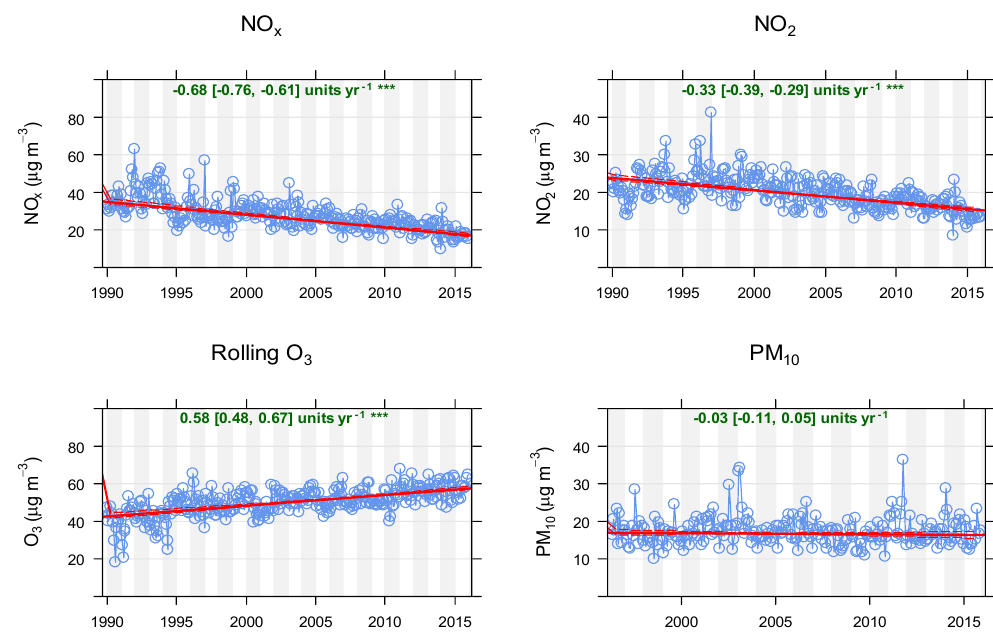
Figure 4. Malmö: trends in NO x , NO 2 , O 3 , and PM 10 , measured from 1990 to 2015. For PM 10 , data are only for the period of 1996–2015. The blue rings are the deseasonalized monthly averages, and the calculated trends using the Theil–Sen method are shown as the red thick lines. The unit for the trends is µgm − 3 year − 1 , and the values in parentheses are 95% confidence intervals. The asterisks ( ∗ ) represent the significance level of the trend lines, where three asterisks means that p< 0 . 001, and one asterisk means that 0 . 01 <p< 0 .